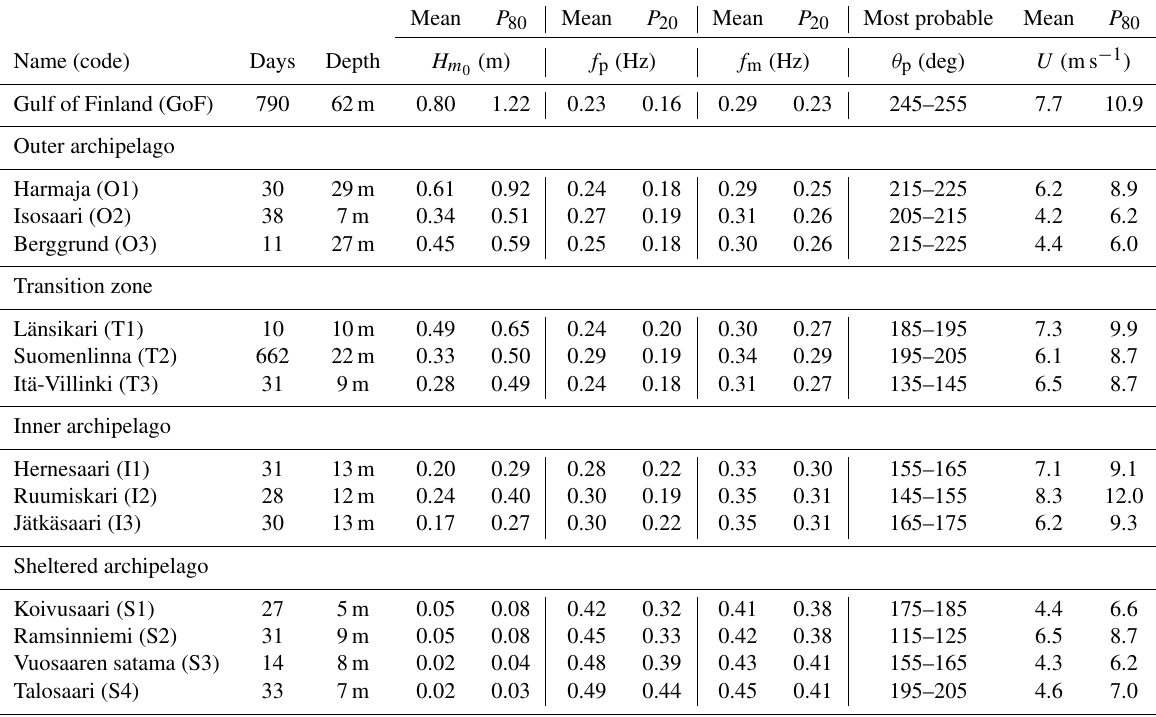
Table 1. The measurement time and depth at the different sites (see Fig. 1 for an overview). The mean and 80th and 20th percentiles are shown for the significant wave height ( H m ), the peak frequency ( f p ), the mean frequency ( f m ), and the 30min wind speed ( U ). The most 0 probable value of the mean direction at the spectral peak ( θ p ) is also shown. All available spectra between 2016 and 2018 (and the coinciding wind data) were used to compile these